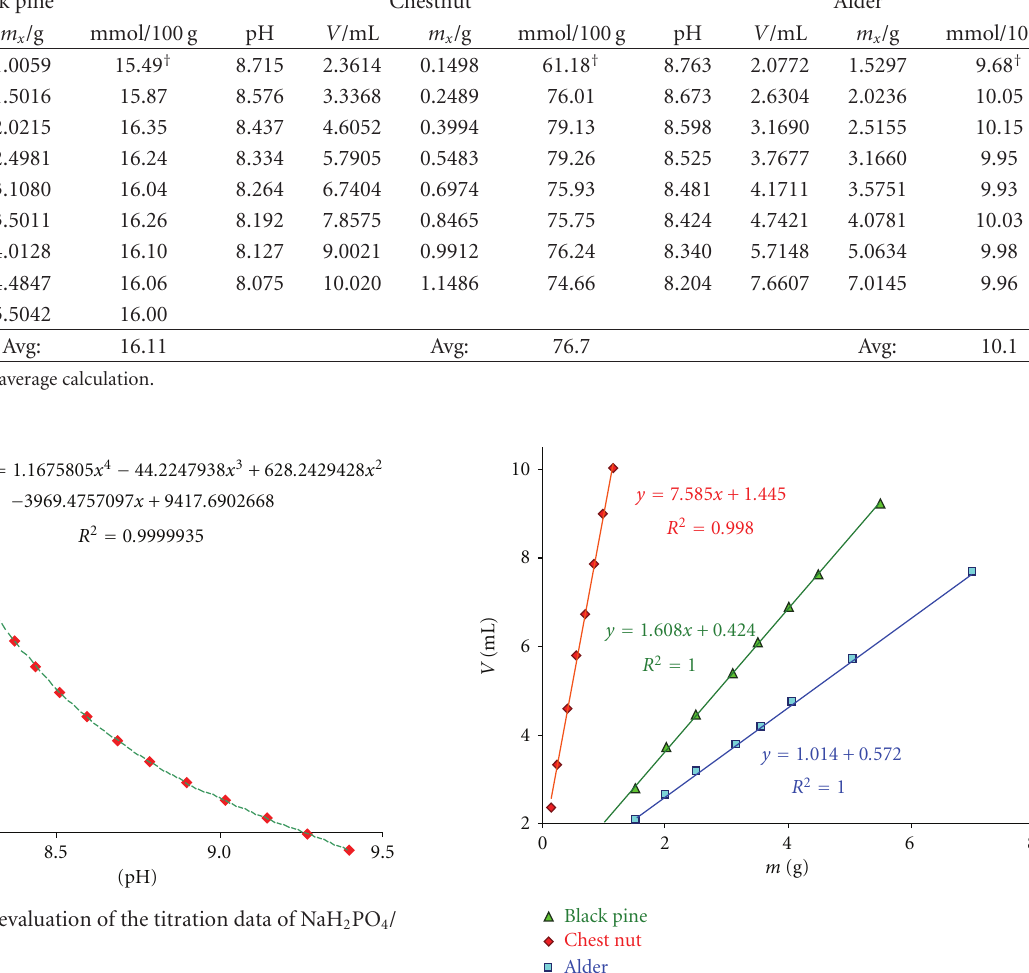
Figure 8: Graphical evaluation of calculated alkali consumption in dependence on sample